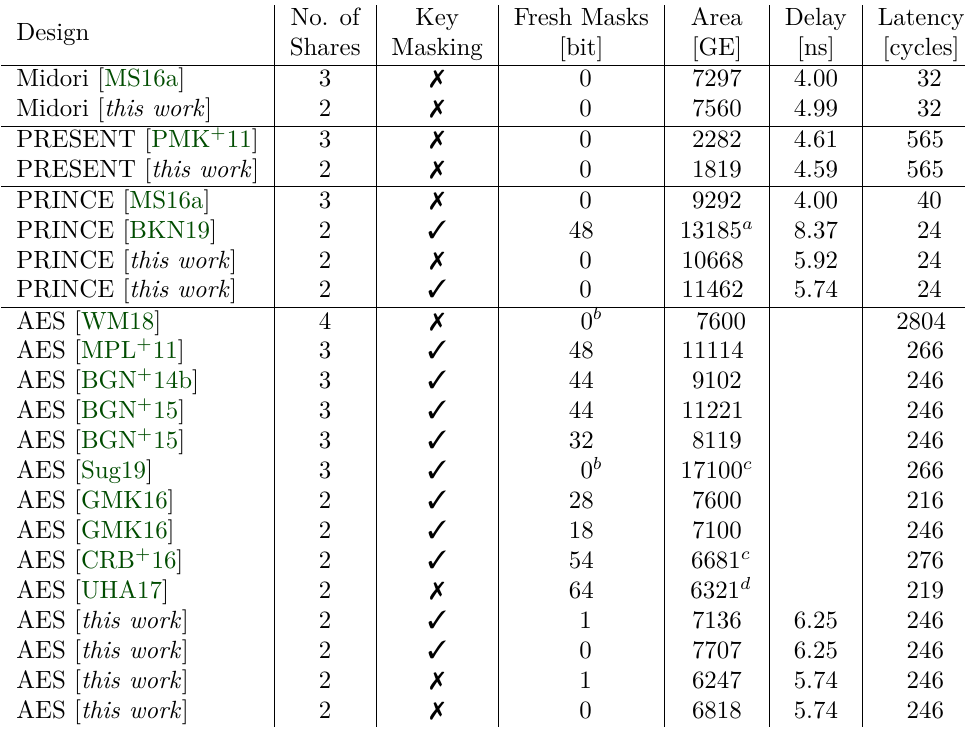
Table 2: Performance figures of different